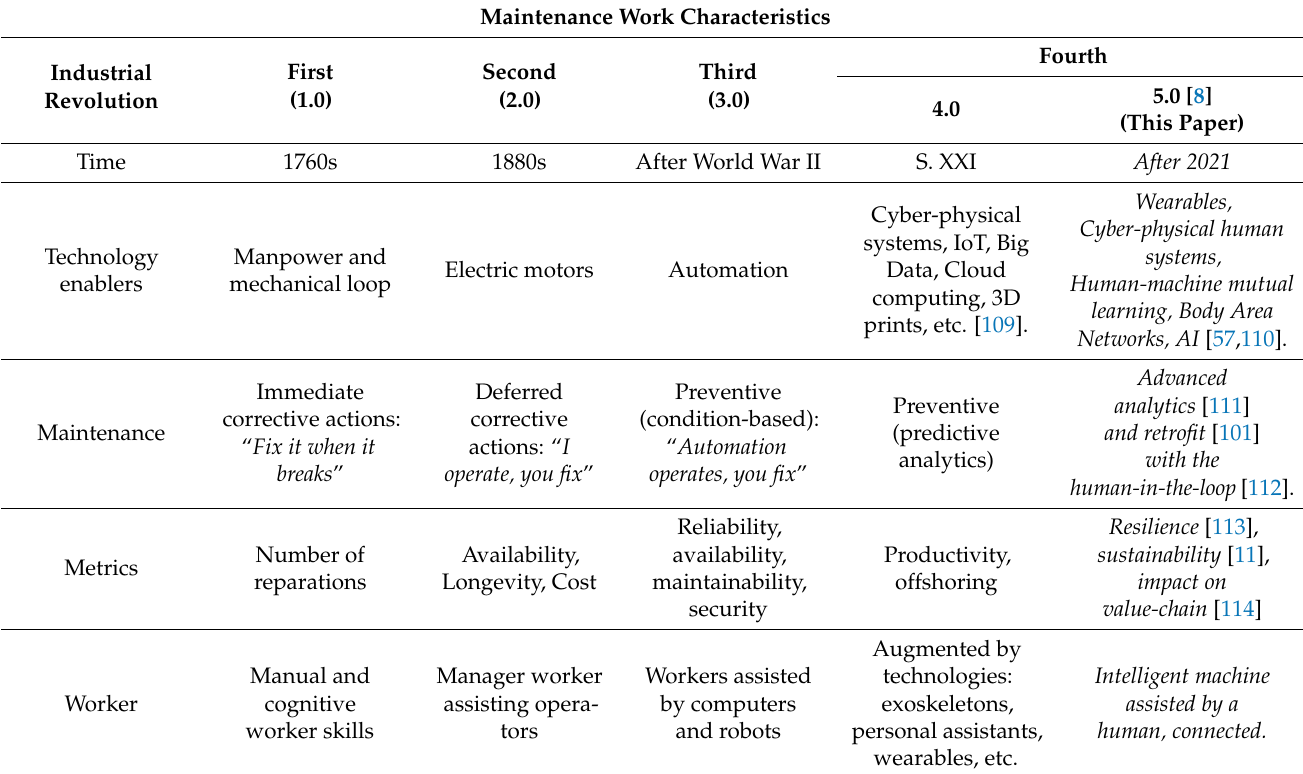
Table 5. Maintenance, Worker, and metrics development. Own elaboration.